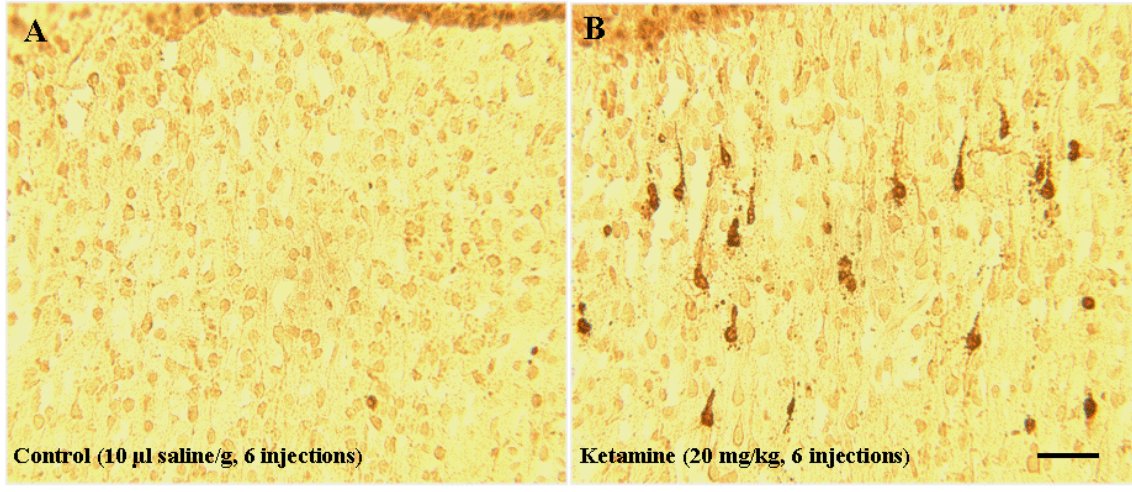
FIGURE 1. Ketamine-induced neurodegeneration in PND 7 rats assessed by TUNEL labeling. Representative photographs indicate that TUNEL-positive cells are more numerous in layers II and III of the frontal cortex in the ketamine-treated rat brain (B). Only a few TUNEL- positive cells were observed in the control (saline-treated) rat brain (A). Scale bar = 60 µm. From Shi et